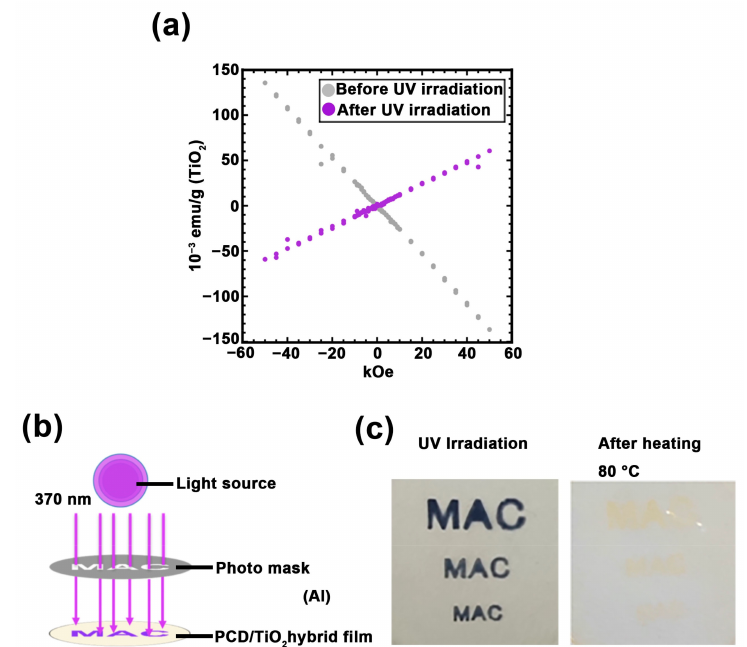
Figure 6. ( a ) Superconducting quantum interference device (SQUID) magnetometer measurements of PC100: before UV irradiation (gray plot) and after UV irradiation (purple plot). ( b ) The image of photolithography of PC100 by UV light source. ( c ) Photograph of PC100 with photolithography and heating treatment.